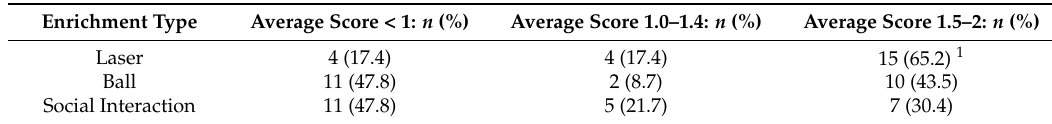
Table 2. Average interest scores for laser, ball, and social interaction across the 23 cats. The number of cats with averages in each range are shown for each enrichment type. A score of 0 indicates no interest, while a score of 2 indicates high